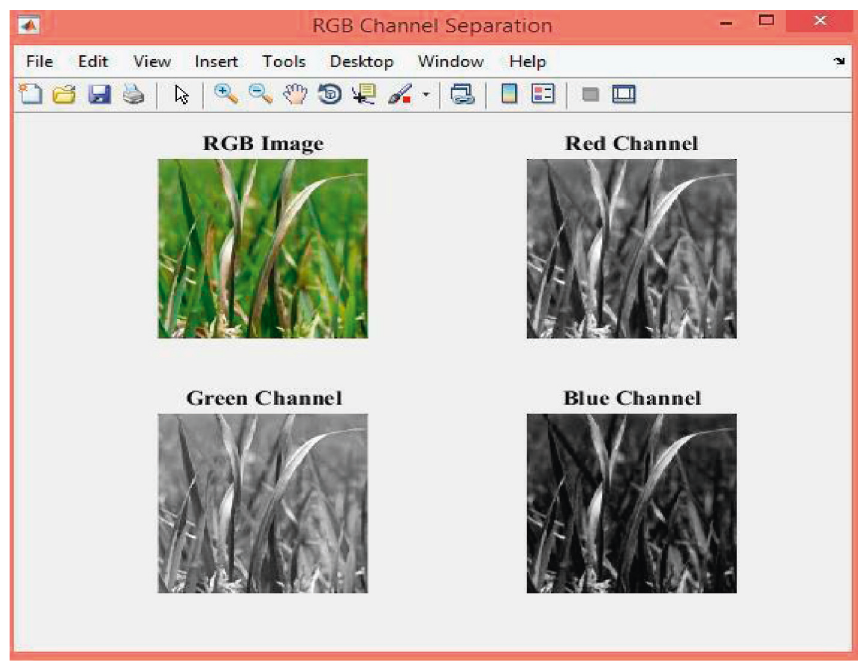
Figure 11: RGB components of bacterial leaf blight in rice plant diseased leaf.